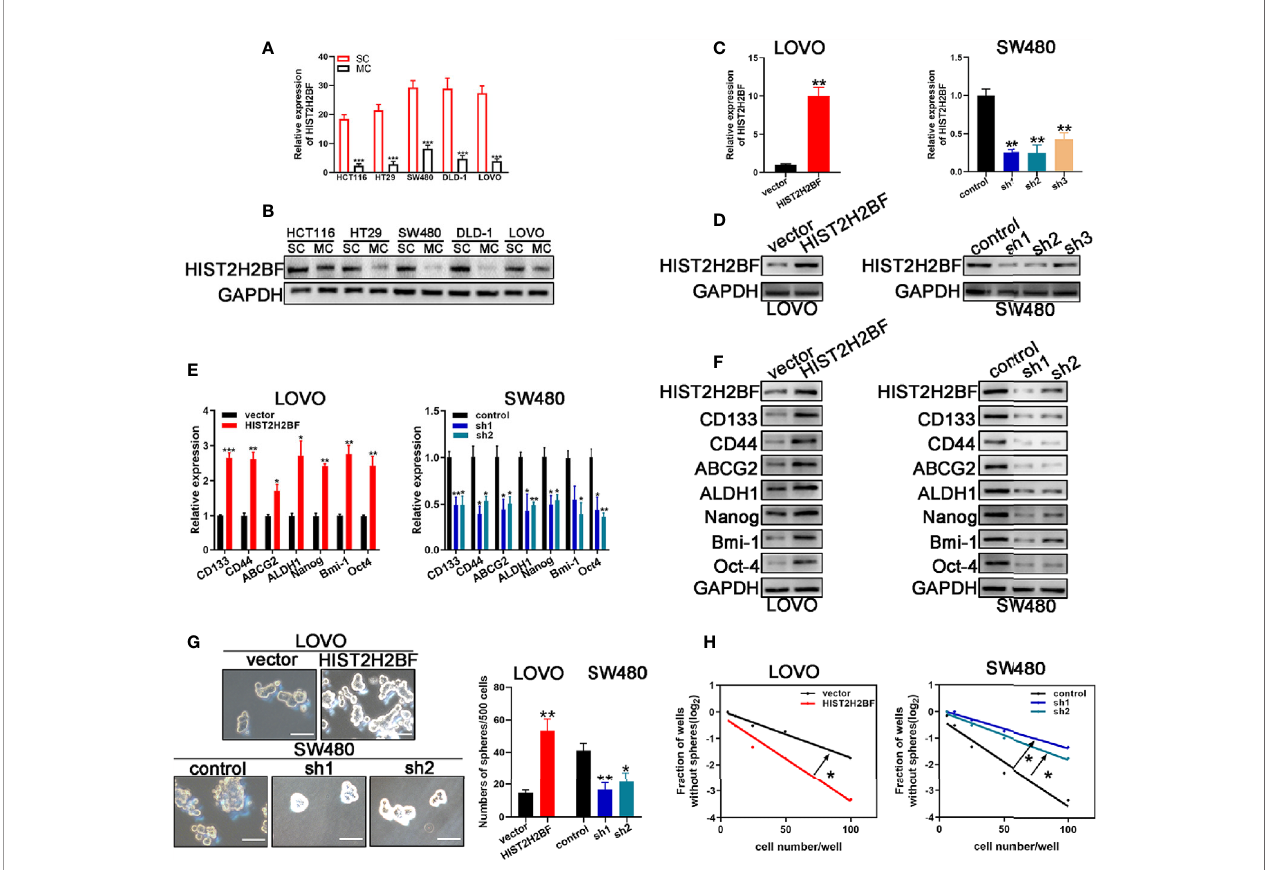
FIGURE 3 | HIST2H2BF promotes stemness of CRC cells. (A, B) Real-time PCR and Western blotting detected HIST2H2BF levels in sphere-forming cells and monolayer cells in CRC cell lines. (C, D) Real-time PCR and Western blotting of HIST2H2BF expression after transfection with lentivirus HIST2H2BF or shHIST2H2BF. (E, F) Real-time PCR and Western blotting of the expression CSC-related biomarkers in LOVO and SW480 cells transfected with lentivirus HIST2H2BF or shHIST2H2BF. (G) Number of spheres in LOVO and SW480 cells infected with lentivirus HIST2H2BF or shHIST2H2BF. Scale bar, 100 m m. (H) LDA determined sphere formation ability following HIST2H2BF overexpression or knockdown. *P < 0.05, **P < 0.01, ***P <